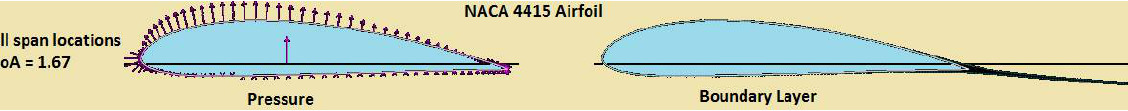
Figure 6. NACA 4415 airfoil properties seen at AoA 1.67 degrees obtained from Xfoil run.